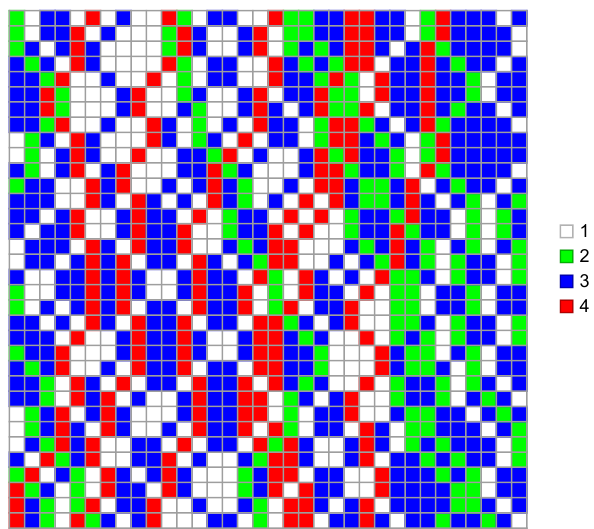
Figure 3: Example for time evolution in the XXC model of type 2 + 2. The initial state is a random configuration with equal weights for the 4 states.